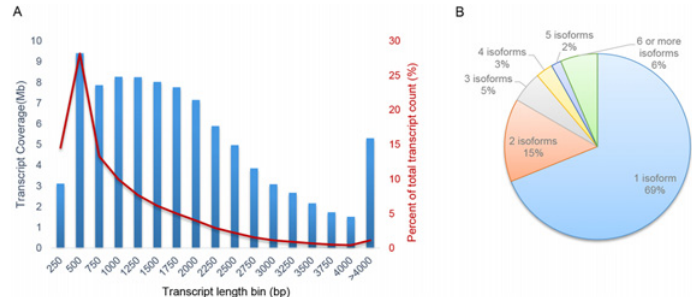
Fig 1. Distribution of assembled transcript length and statistic of isoform pattern. (a) Distribution of assembled transcript length binned at 250bp intervals. (b) The percentage of transcript isoform pattern ranging from a single isoform to 6 or more isoforms in a single assembled gene.